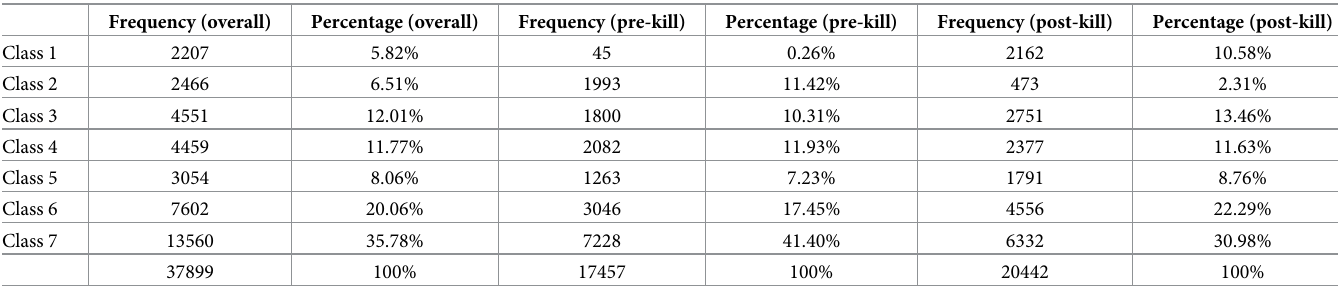
Table 2. Number of tweets classified into each category.